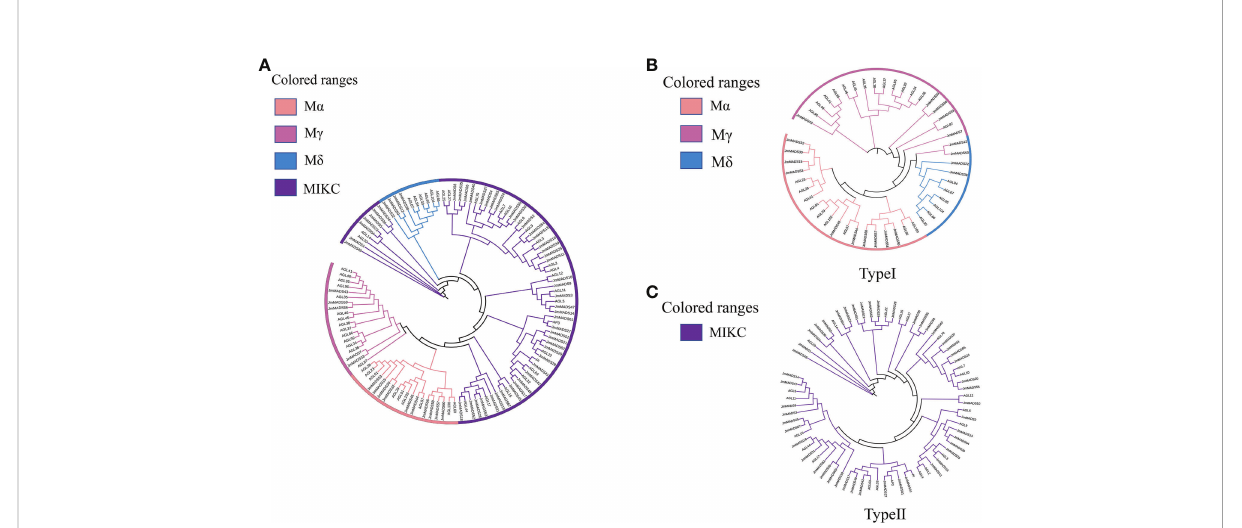
FIGURE 1 Phylogenetic trees. (A) Phylogenetic relationship of MADS-box proteins between J. mandshurica and A. thaliana . Four classes are represented by branches with different colors, including M a (light pink), M g (deep pink), M d (blue), and MIKC (purple). Phylogenetic tree of type I (B) and type II (C) MADS-box domain proteins in J. mandshurica plants. The phylogenetic tree was constructed using MEGA 7.0 software and the neighbor- joining method with the following parameters: bootstrap analysis of 1,000 replicates, Poisson model, and pairwise